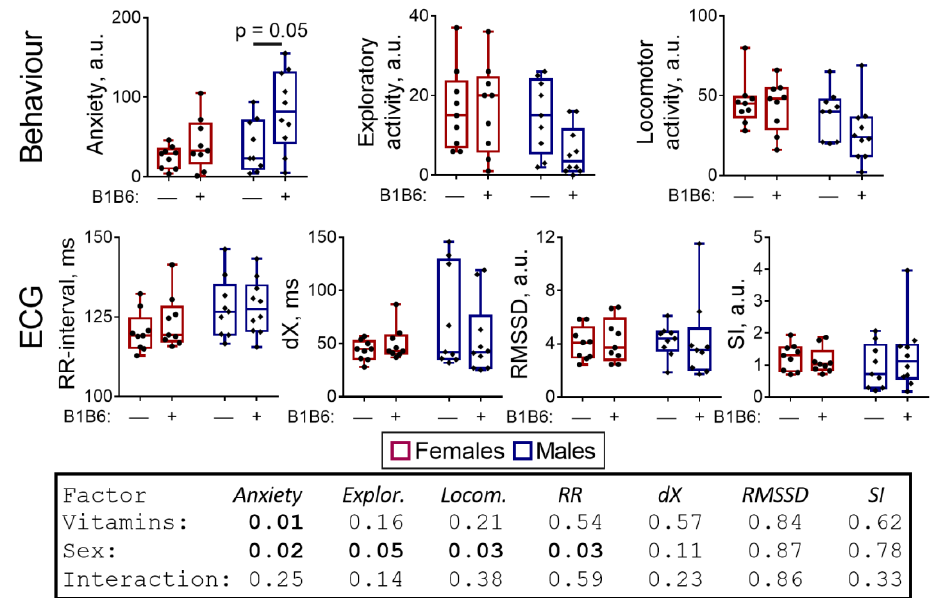
Figure 7. Physiological effects of the administration of vitamins B1 and B6 to the control rats. The studied parameters are indicated on Y axes and described in detail in Figure 1 and “Materials and methods”. The statistical analysis of the data was performed by the two-way ANOVA with Tukey’s post hoc test (see Section 4).